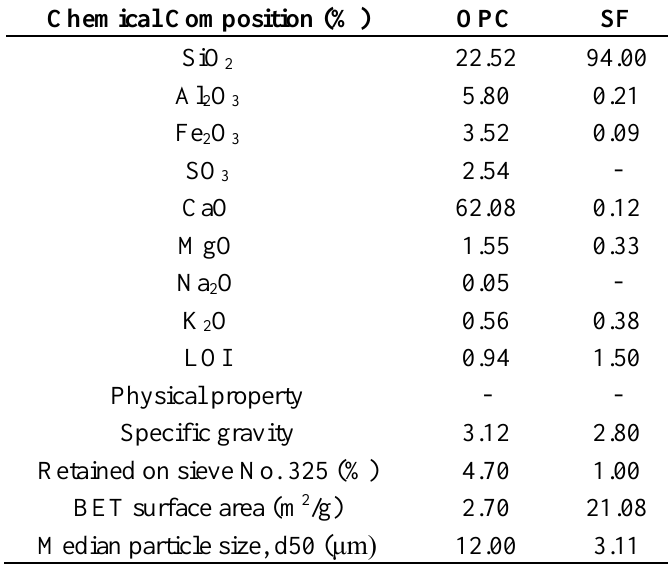
Table 3. Chemical and physical properties of OPC and